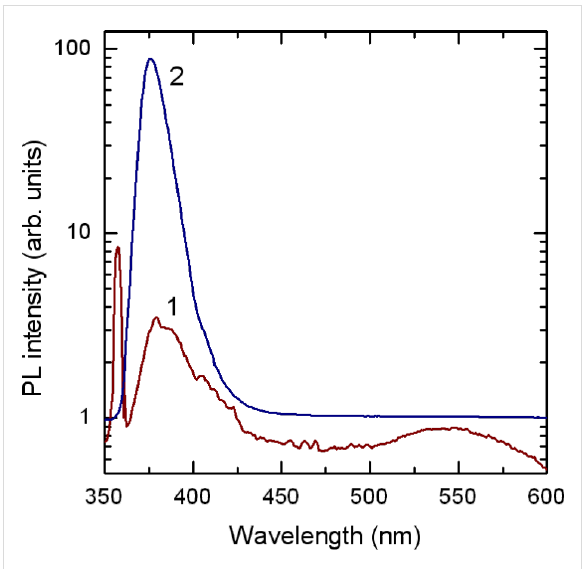
Figure 2: PL spectrum of PVP-capped ZnO nanoparticles (sample 1, curve 1) and PL spectra of ZnO bulk crystal (curve 2).